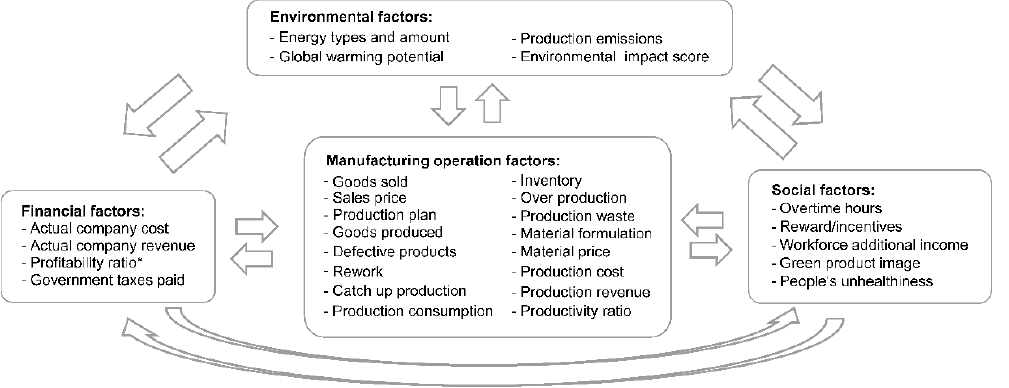
Figure 1. Sustainable factors, criteria, and inter-connections within cosmetics small and medium industries (SMIs) [26].